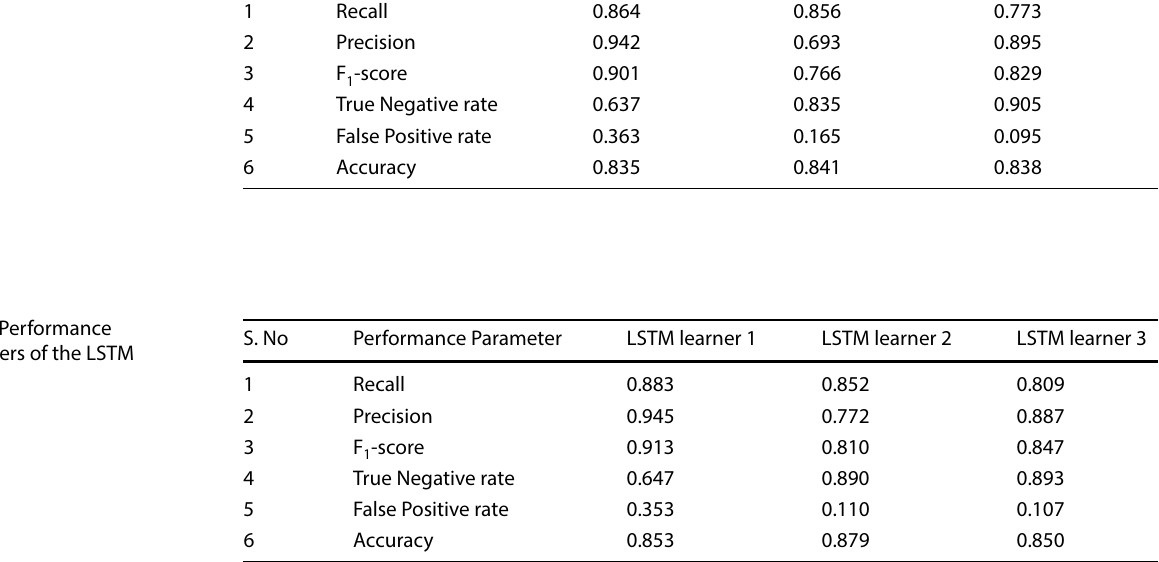
Table 8 Performance parameters of the standard neural network learners